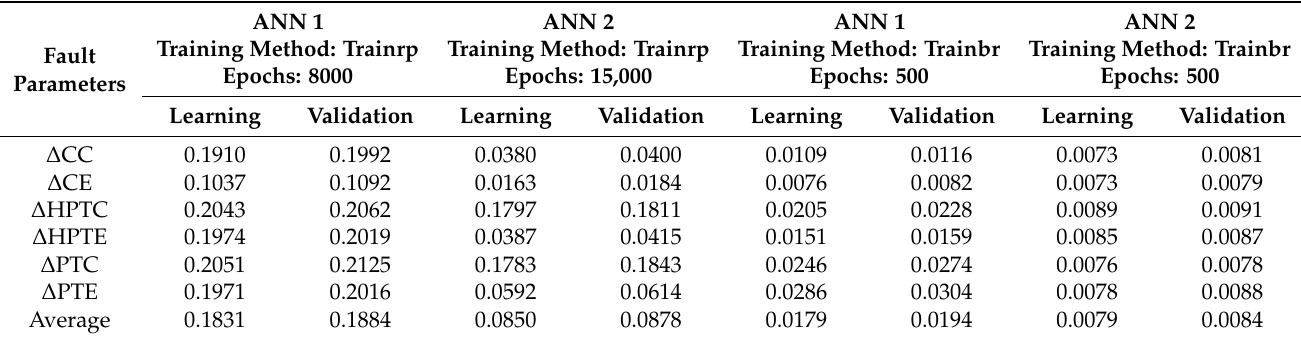
Table 2. RMSE for MLP configurations of one regime diagnostic model (turbo shaft, relative spool speed 1.0).